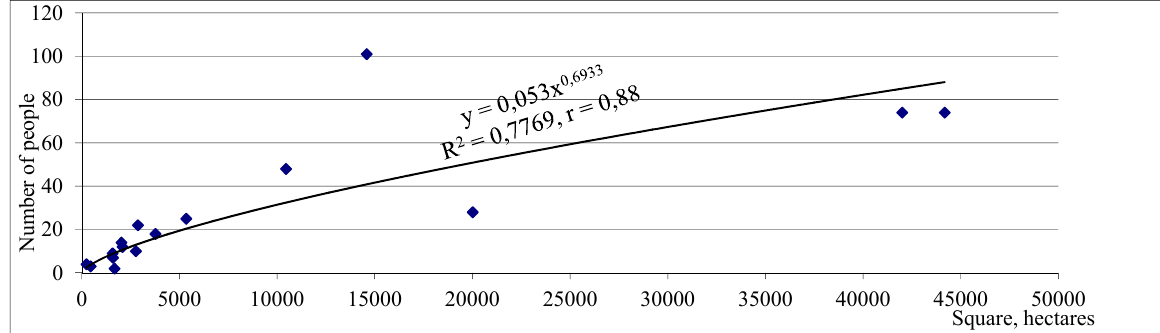
Fig. 3. Dependence of the number of employees on the square of nature reserves